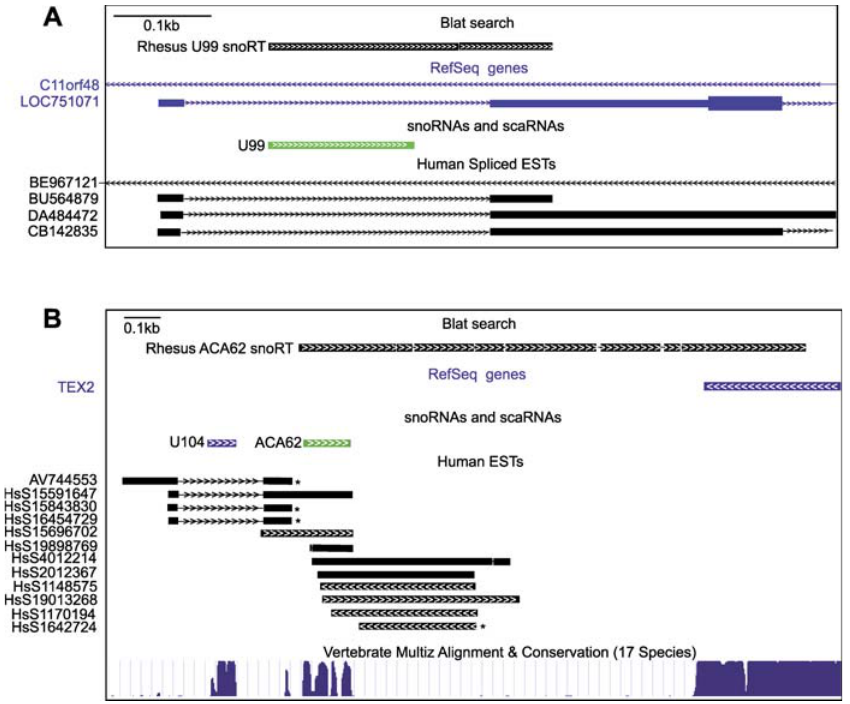
Figure 2. Characterization of snoRNA Host Genes by Analysis of snoRNA Retroposons (A) The human U99 HG. This figure, redrawn from a UCSC Genome Browser screen, shows results of the alignment of a rhesus-specific U99 snoRT with the human genome (Blat Search track), and the position of the human U99 snoRNA gene and of human spliced ESTs. For clarity, only 4/45 spliced ESTs in this window are shown. The human sequence orthologous to the retroposon starts at the 5 9 end of U99 and ends at the 3 9 end of six ESTs, like BU564879. The corresponding transcription unit, the U99HG (RefSeq gene LOC751071), resides in an intron of the C11orf44 gene in the antisense orientation. The BE967121 EST corresponds to the C11orf48 gene, but the others were erroneously included in the Hs.9061 (C11orf48) UniGene cluster. Window shown: chr11:62,189,300–62,190,050 (hg18). (B) The human U104/ACA62 HG. This UCSC screen copy shows the alignment of selected ESTs from the Hs.405444 UniGene cluster and of a rhesus- specific ACA62 snoRT with the human genome. The position of the U104 and ACA62 snoRNAs is also shown. The asterisks indicate the presence of a polyA tail in the EST sequences. The presumptive U104 ACA62 HG is larger than the UniGene cluster and overlaps the 3 9 UTR of the TEX2 gene in the antisense orientation. The lower track shows the lack of conservation of the HG outside of the snoRNA